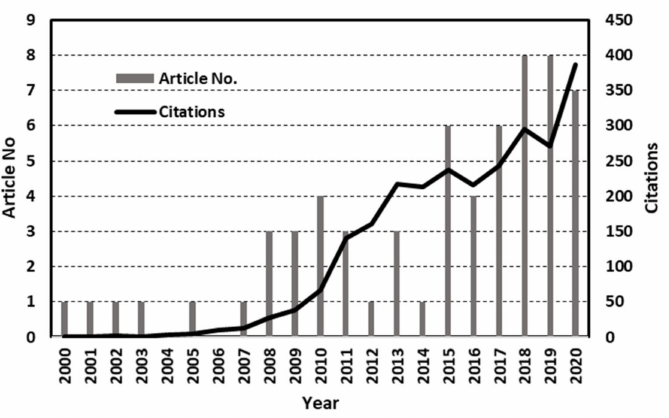
Figure 13. Number of articles (Article No.) on partial oxidation reactions and related